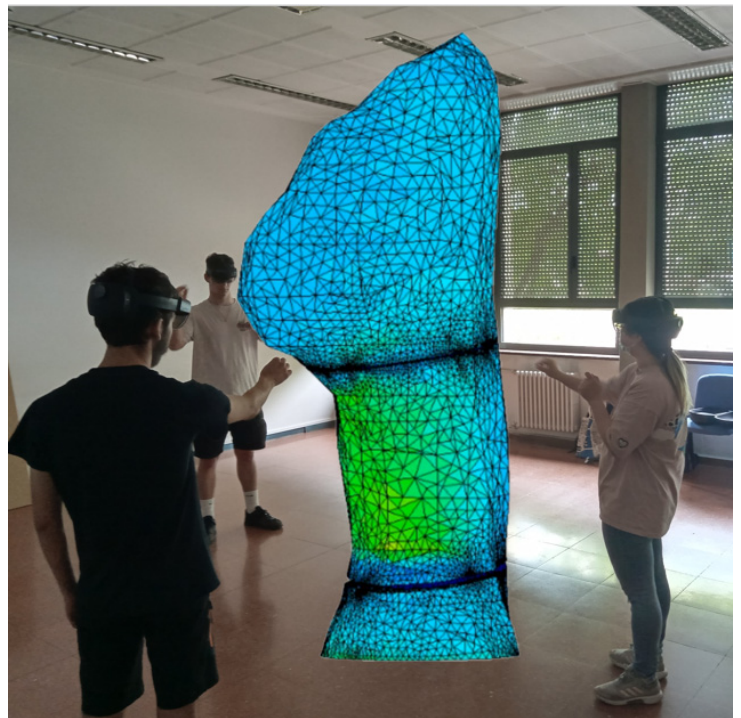
Figure 22. “ Cadireta” (Montserrat): visualization concept of FEM results in MR. The conglomerate elements are colored according to the value of the tension first invariant (P), ranging from light blue (near zero) to yellow (close to 2 MPa).